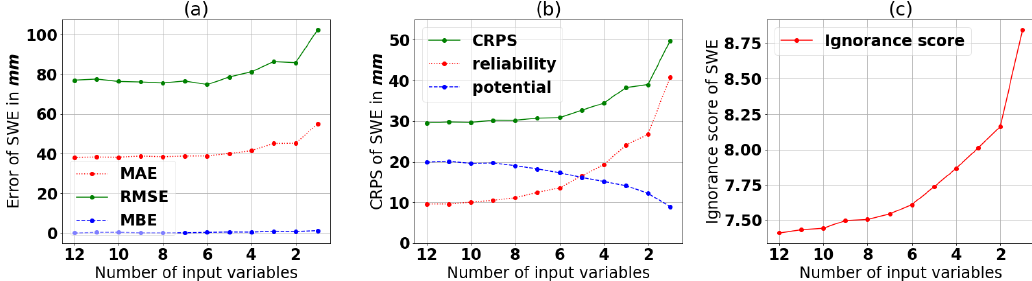
Figure 7. Stepwise reduction of input variables, ordered according to their influence as determined in Table 4. The scores are evaluated using the validation data set. The Combo setup from Table 3 is used.